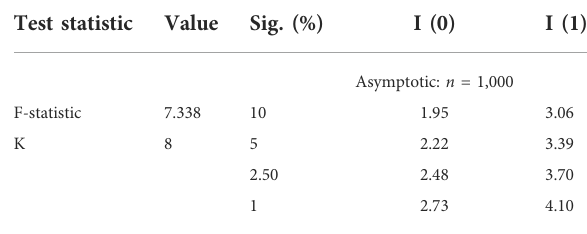
TABLE 4 ARDL bound